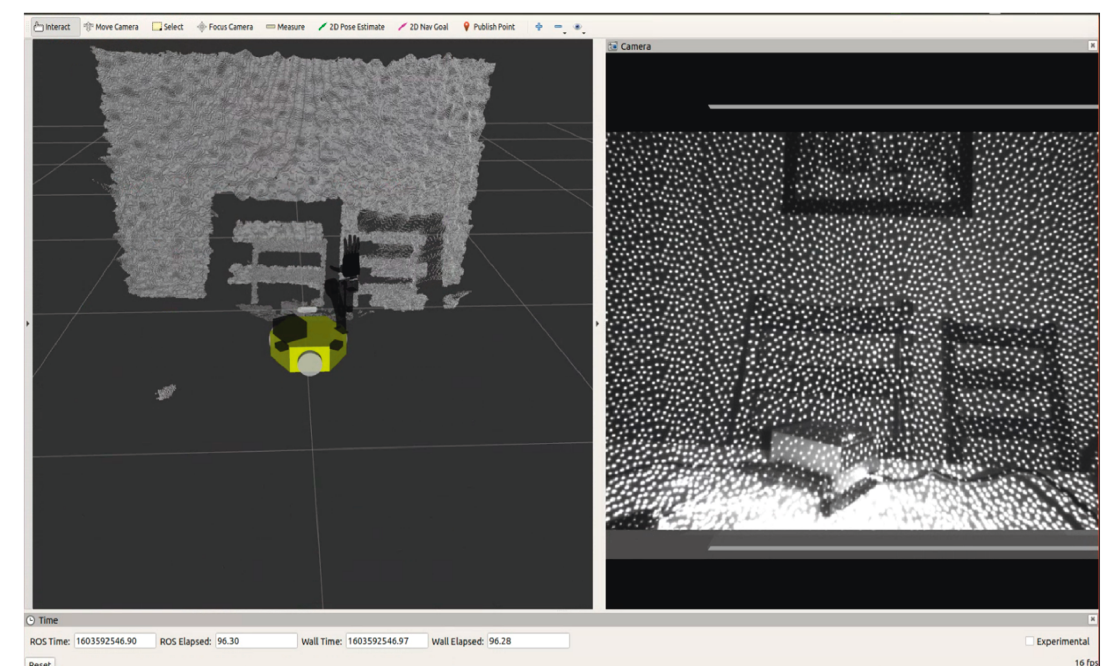
Figure 14: User interface for BCI-controlled motion.